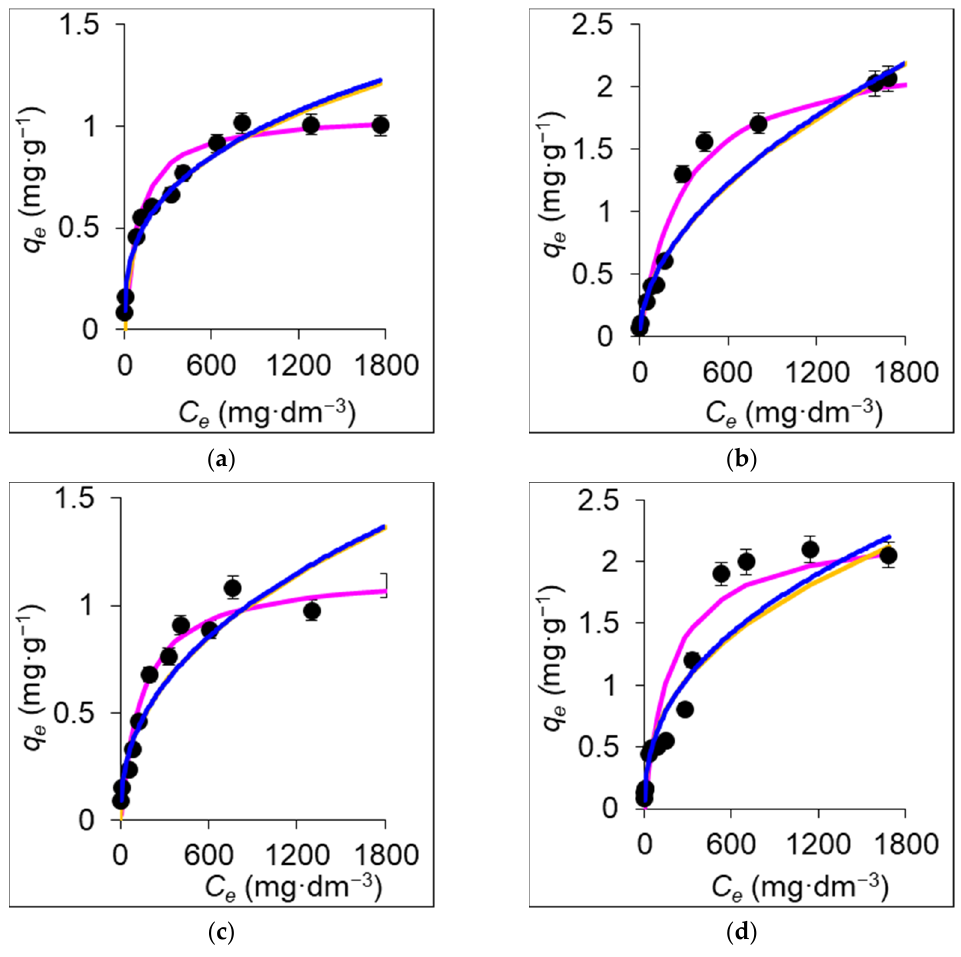
Figure 1. Experimental data of Cu sorption on Z-M20 from ( a ) CuSO 4 ( b ) Cu(NO 3 ) 2 , and Zn sorption on Z-M20 from ( c ) ZnSO 4 ( d ) Zn(NO 3 ) 2 . Note: black dots—experimental data ± standard deviation; blue line—Freundlich isotherm, pink line—Langmuir isotherm, orange line—Redlich– Peterson